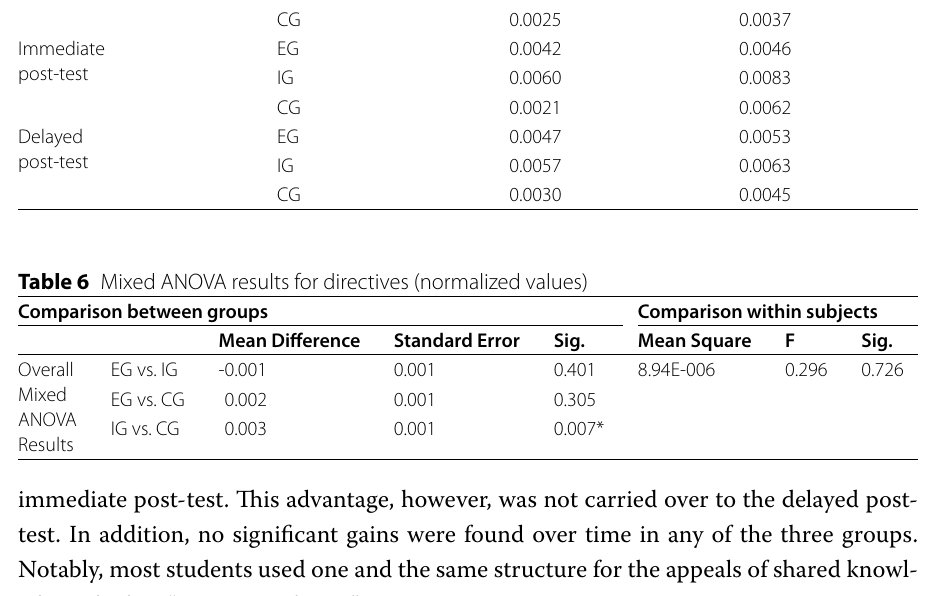
Table 5 Descriptive statistics for directives (normalized values) Group Mean Standard deviation Pre-test